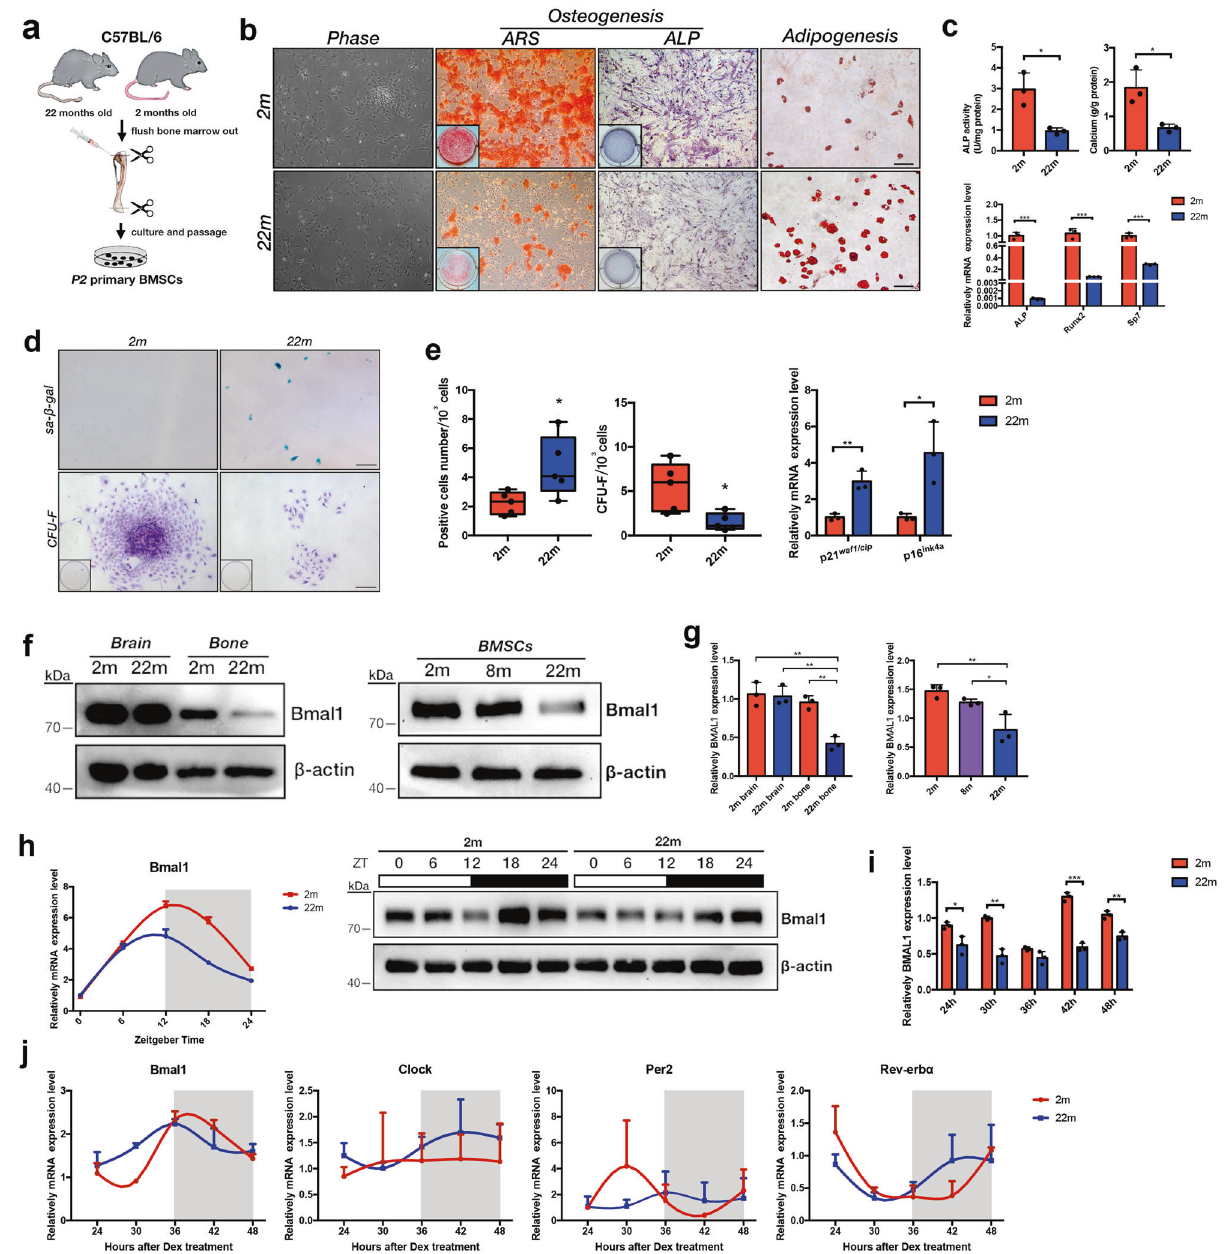
Fig. 1 The circadian molecular rhythm was abolished, and Bmal1 expression decreased in bone and BMSCs with aging. a Work fl ow diagram of BMSCs isolation. b Morphological images, Alizarin red, ALP and Oil Red staining of 2-months and 22-months BMSCs under osteogenic and adipogenic conditions. Scale bar: 200 μ m. c Quantitative analysis of ALP and ARS staining and qRT-PCR analysis of osteogenic- related gene expression ( Alp, Run2 , and Sp7 ) in 2-month and 22-month BMSCs. d CFU-F and SA- β -gal staining of 2-months and 22-months BMSCs. Scale bar: 200 μ m. e Quantitative analysis of the numbers of colonies and senescent cells, qRT-PCR analysis of senescence-associated secreted phenotypes ( p16 ink4a , p21 waf1/cip ) . f Western blot analysis of Bmal1 expression in Brain tissue, Bone tissue and BMSCs in mice with different ages. g Quantitative analysis of data in f. h qRT-PCR and western blot analysis of Bmal1 circadian expression in BMSCs aged two months and 22 months. Cells were harvested at ZT0, ZT6, ZT12, ZT18, and ZT24. i Quantitative analysis of data in ( h ). j qRT-PCR analysis of molecular rhythmic expression of circadian clock genes ( Bmal1, Clock, Per2 , and Rev-erb α ) in 2-month and 22-month BMSCs under osteogenic conditions. N = 3-5, Data are presented as mean ± SD; * p < 0.05, ** p < 0.01, *** p < 0.001 ( c , e , i ) by two-tailed Student ’ s t -tests and ( g ) by one- way ANOVA with Tukey ’ s post hoc expressed and shown in the Volcano map (Fig. 4d). Fold changes most enriched pathways (Fig. 4b). Focus on the Hippo pathway of Hippo pathway core genes were con fi rmed and showed with ( p = 0.002, enrich factor = 0.668), the enriched peak of BMAL1 heatmap (Fig. 4e). Collectively, the Hippo pathway was considered was found on the TTS region of Yap1 using IGV tools (Fig. 4c). as the potential downstream pathway involved in Bmal1 We further mined the GSE106586 RNA-seq dataset to screen the regulation of BMSCs osteogenic lineage commitment. To inves- mRNAs expression pro fi le on Bmal1-knockout and wildtype tigate whether Hippo signaling pathway is regulated by the BMSCs. A total of 849 genes were de fi ned as differentially